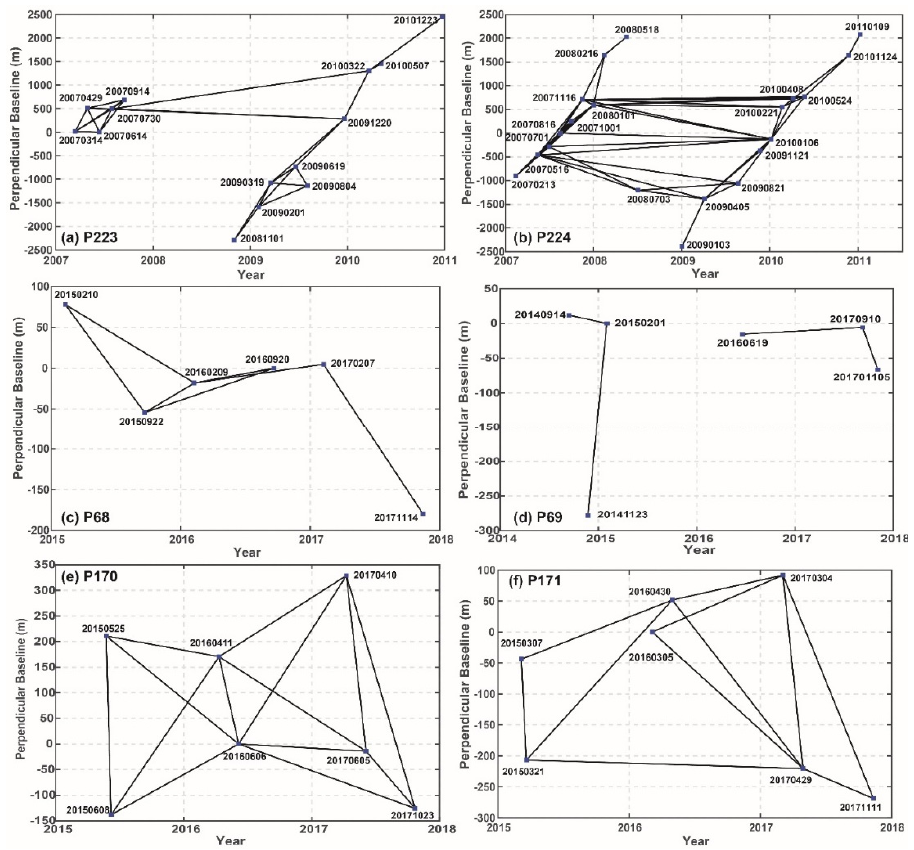
Figure 2. Temporal-spatial baseline distribution of selected interferograms used in this study. The SAR acquisition dates are shown in the format of YYYYMMDD (e.g., 20070314) while Y-axis represents the perpendicular baseline of the interferogram. ( a ) and ( b ) show the interferograms generated by ascending ALOS PALSAR-1 data for Path 223 (P223) and Path 224 (P224); ( c ) and ( d ) show the interferograms generated by ascending ALOS PALSAR-2 data for Path 68 (P68) and Path 69 (P69); ( e ) and ( f ) show the interferograms generated by descending ALOS PALSAR-2 data for Path 170 (P170) and Path 171 (P171).